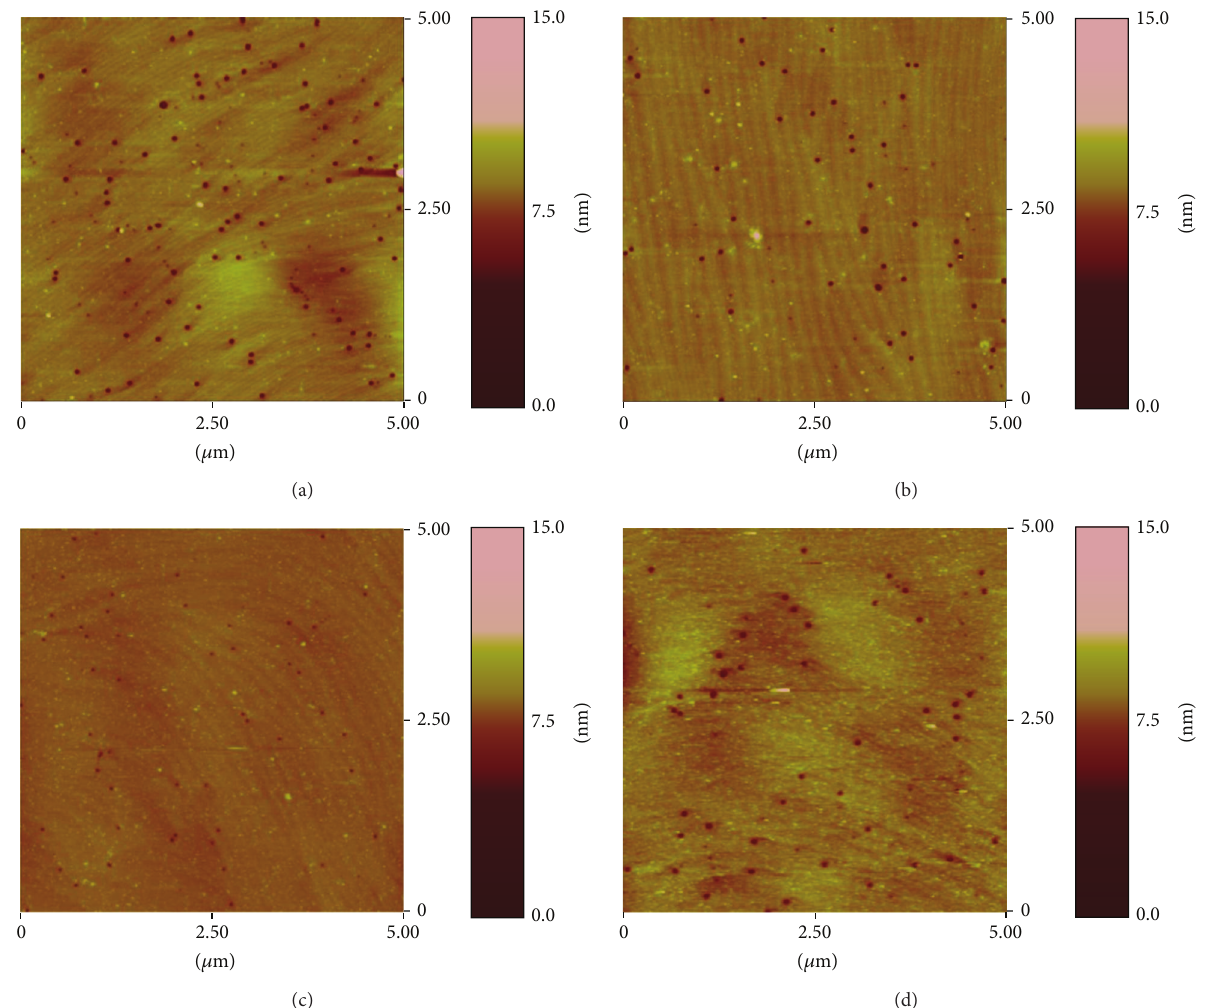
Figure 5: The EPD images over 5 × 5 𝜇 m 2 scanning area of (a) sample-C, (b) sample-R, (c) sample-T, and (d) sample-P.